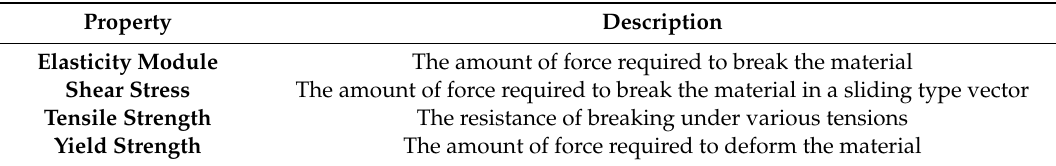
Table 1. Characteristics of metals used in maxillofacial